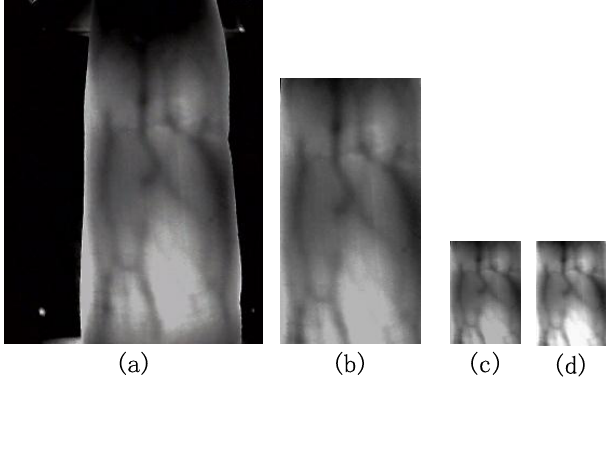
Figure 5. Examples of preprocessing. ( a ) Original image. ( b ) ROI extraction. ( c ) Size normalization. ( d ) Gray